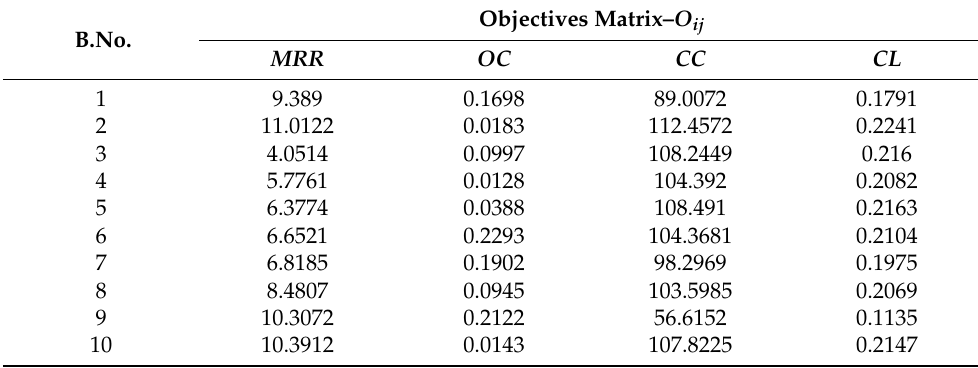
Table A2. Response values of bees.